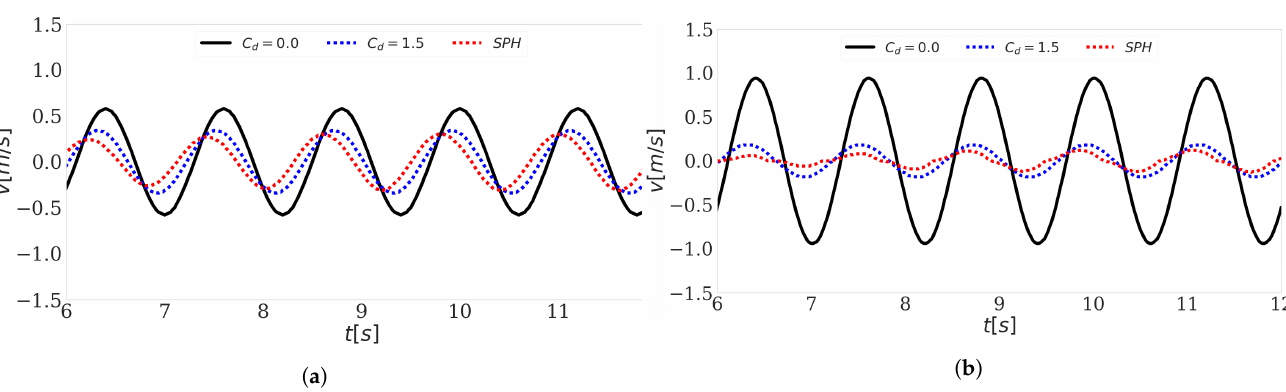
Figure 11. Velocity of cylinder2 with ( a ) a linear damping PTO system, B PTO , l = 25 Ns/m and ( b ) a Coulomb damping PTO system , B PTO , c = 10 N calculated with linear potential flow theory with (i) C d = 0.00, (ii) C d = 1.50 and (iii) with DualSPHysics— H = 0.15 m, T = 1.2